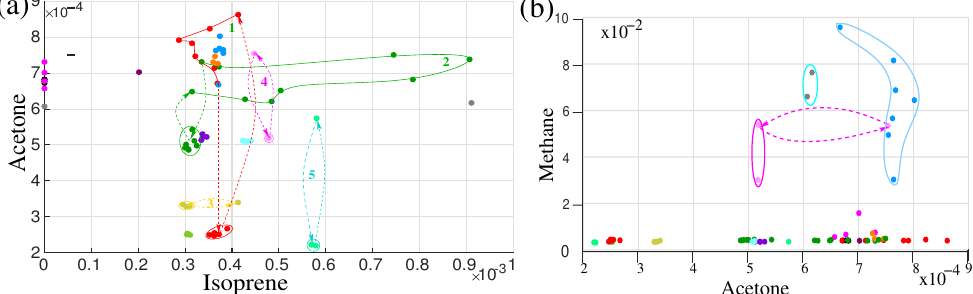
0 Figure 7. Two-dimensional illustration of different effects affecting the IOS on isoprene-acetone ( a ) and acetone-methane ( b ) plots. The same colours in the plots correspond to the same volunteers. Dashed lines are used to visualize the trajectory of the concentration variation of VOCs for different effects. The red colour plot represents the fasting effect and the green trajectory represents circadian variation.